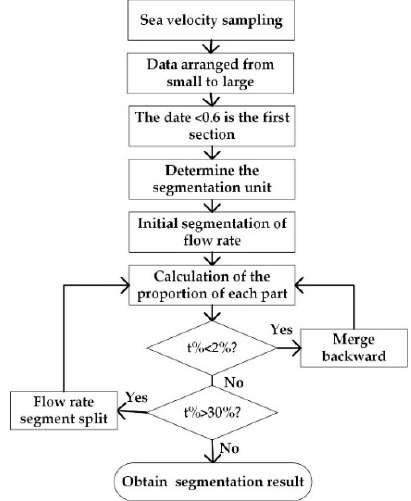
Figure 2. Tidal current period velocity segmentation flowchart.